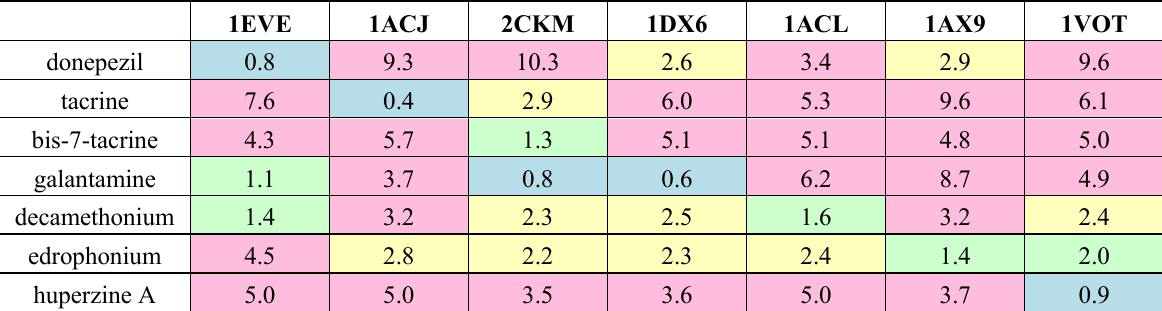
Table 3. Results of cross-dockings to seven analyzed crystal structures of AChE. Assessment with rmsd values (blue: good pose; green: close pose; yellow: pose with errors; pink: bad